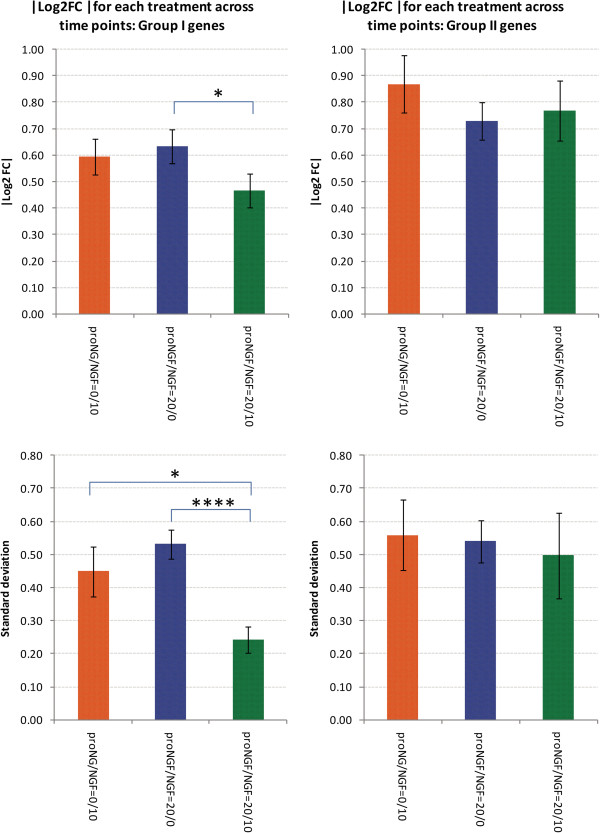
Histograms of Log2 Fold Change for analysed genes, following single neurotrophin and equimolar mixture treatments. (Upper panel) Average |Log2 Fold Change| (absolute value across time points) in the two groups of genes, with the treatments with NGF (proNGF/NGF 0/10 ng/ml), proNGF (proNGF/NGF 20/0 ng/ml) and the equimolar mixture of proNGF/NGF 20/10 ng/ml. (Lower panel) Average standard deviation (across time points) of |Log2 Fold Change| in the two groups of genes, with the treatments with NGF (proNGF/NGF 0/10 ng/ml), proNGF (proNGF/NGF 20/0 ng/ml) and the equimolar mixture of proNGF/NGF 20/10 ng/ml. The mixture shows a weaker response in Group I genes, as underlined also by a much smaller variability across time. (****) 1-tail T-test with unequal variance, p < 0.0001. (*) 1-tail T-test with unequal variance, p < 0.05. Error bars are s.e.m.